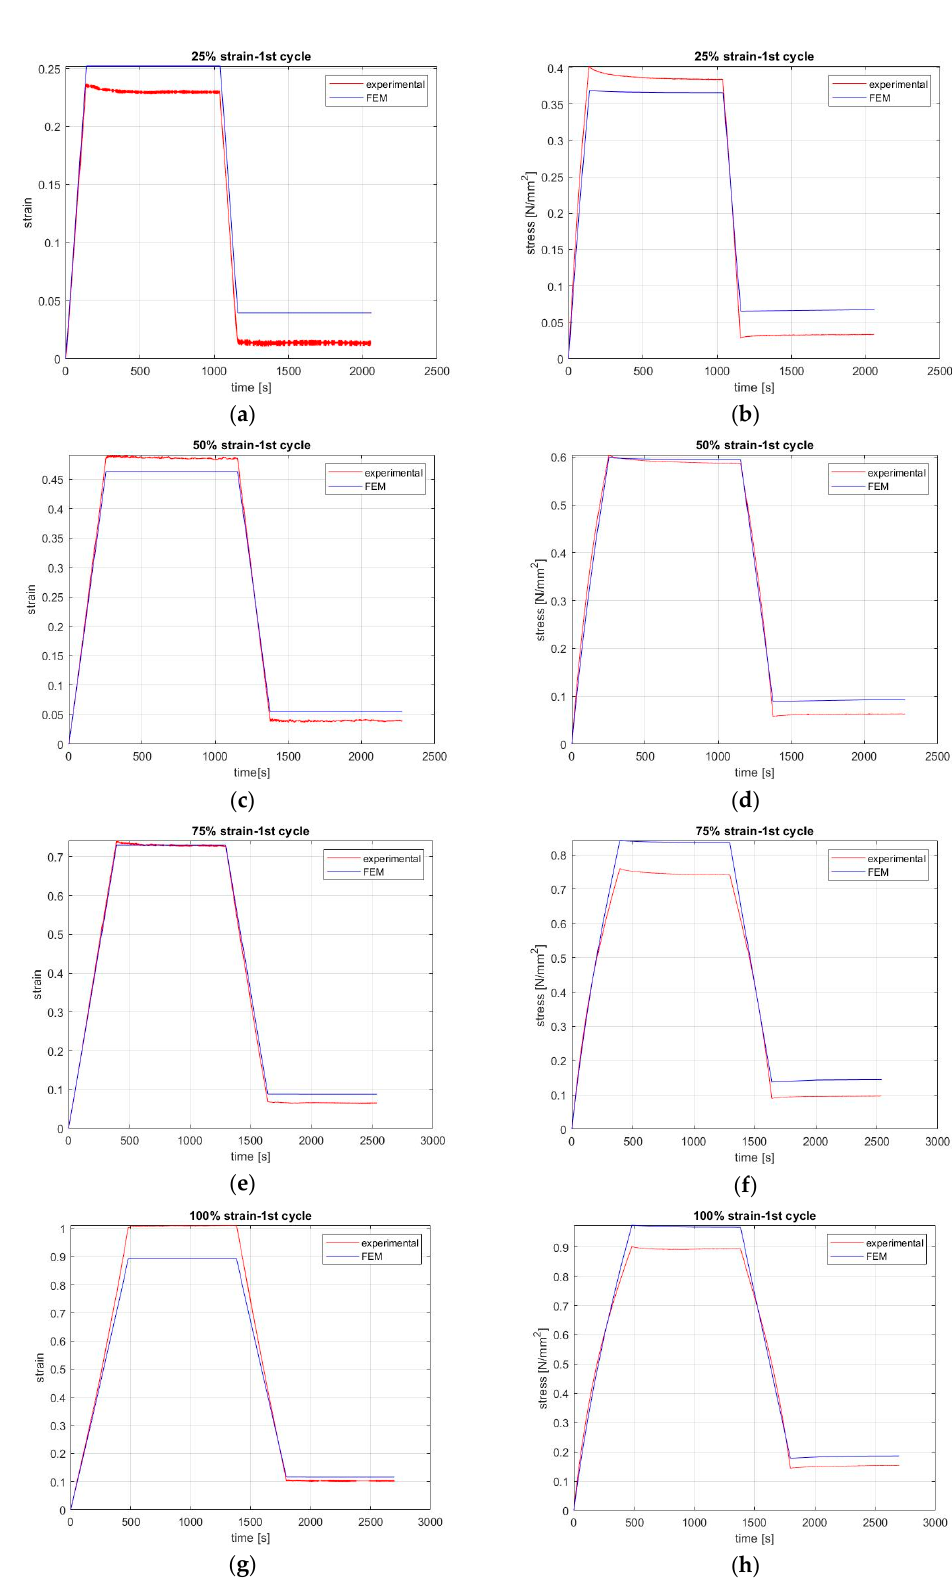
Figure 4. FEM compared with experimental results for the first cycle. Graphs in the left column show the history of applying ( a ) 25%, ( c ) 50%, ( e ) 75%, and ( g ) 100% strain and partially removing it until it reaches 10% of the applied strain (cause). Graphs in the right column show the stress response following the application and removal of ( b ) 25%, ( d ) 50%, ( f ) 75%, and ( h ) 100% strain as a step function (e ff